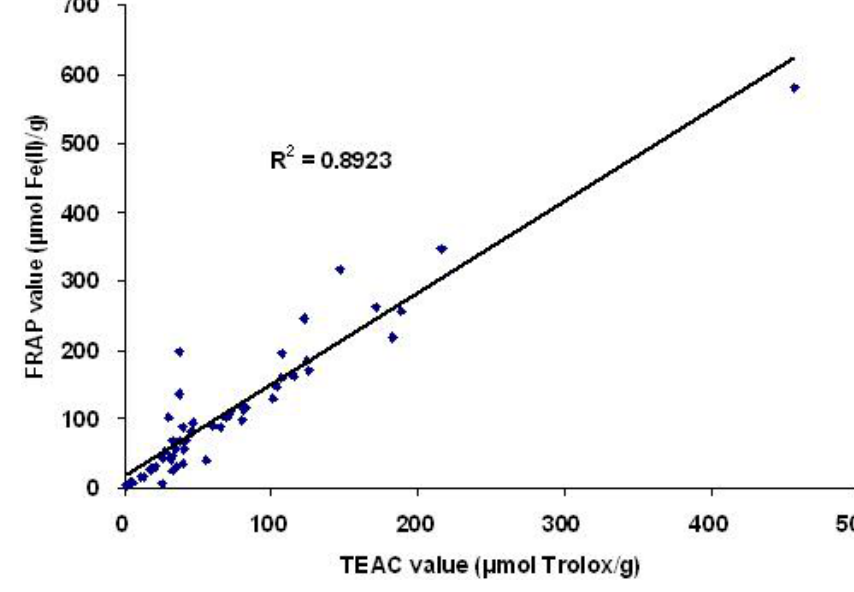
Figure 1. Correlation between the antioxidant capacities measured by the FRAP and TEAC